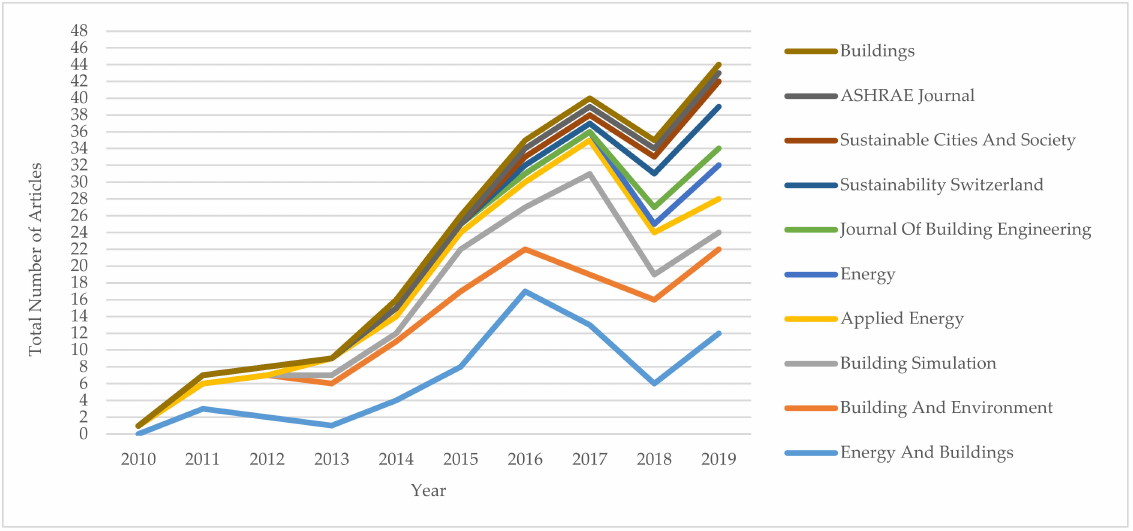
Figure 2. The trend in keyword “Occupant Behavior”.